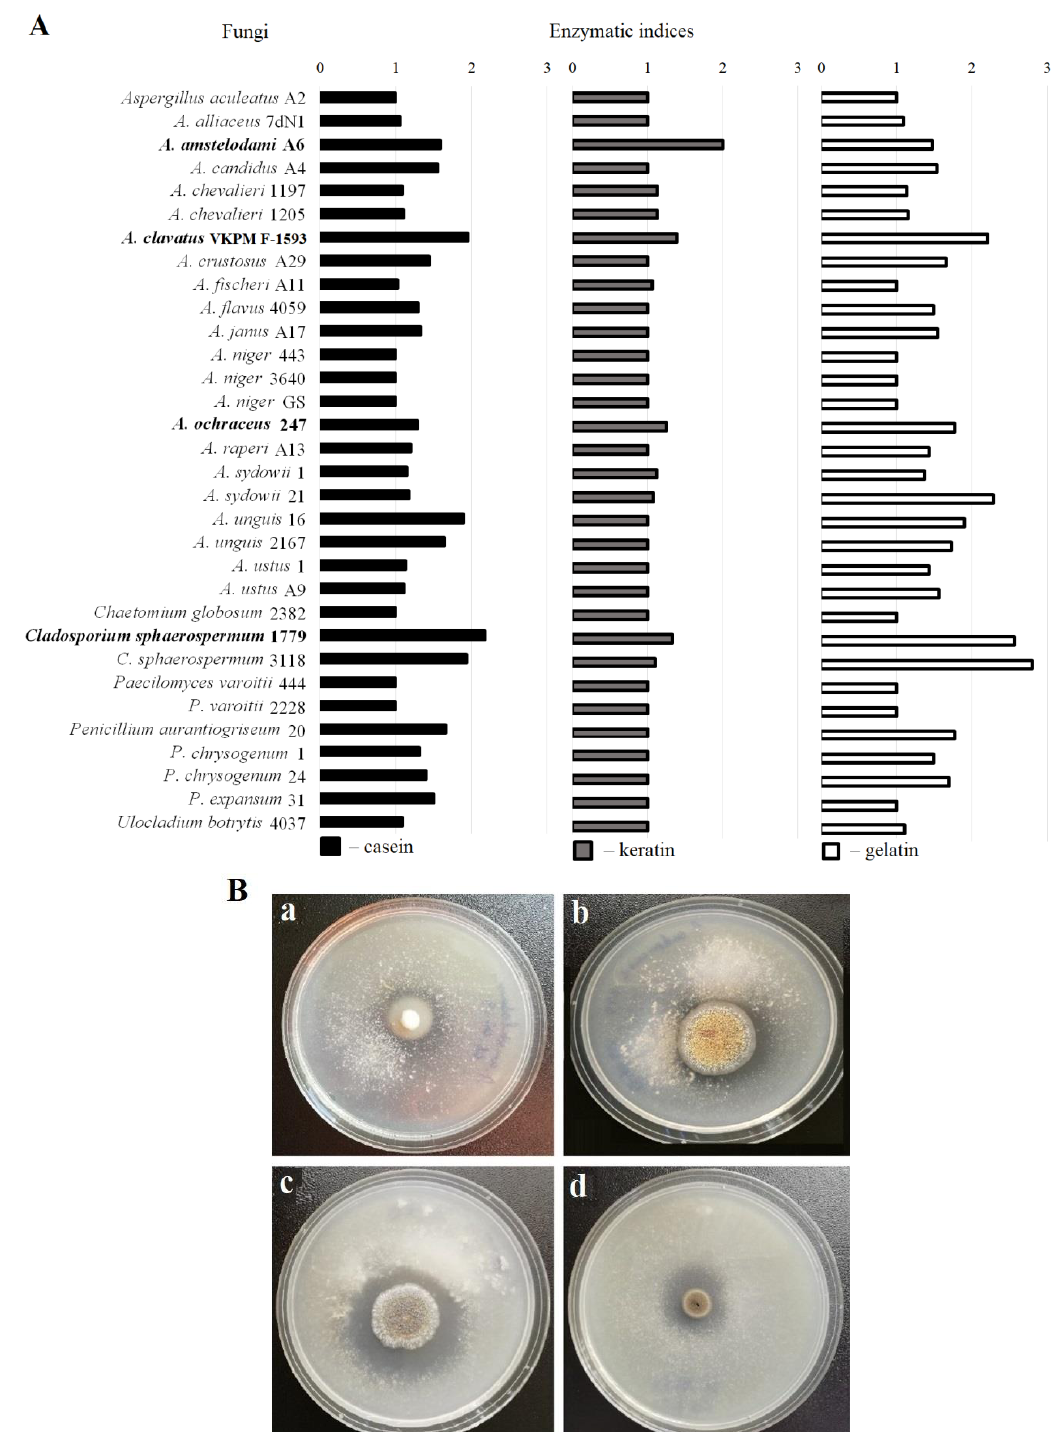
Figure 1. Screening for keratinolytic fungi on agar media. ( A ) Enzymatic indices (EI) of the studied strains grown on protein-containing agar plates. The media contained 1.0% casein (black), 0.5% keratin (grey), and 1.0% gelatin (white). The fungi in bold demonstrated the highest EI value on the keratin medium in combination with the presence of hydrolysis zones on the casein and gelatin media and were selected for further investigation. The experiment was done in triplicate. ( B ) Selected fungi on the casein agar medium after 5 days of cultivation: ( a ) A. amstelodami A6, ( b ) A. ochraceus 247, ( c ) Aspergillus clavatus VKPM F-1593, and ( d ) Cladosporium sphaerospermum